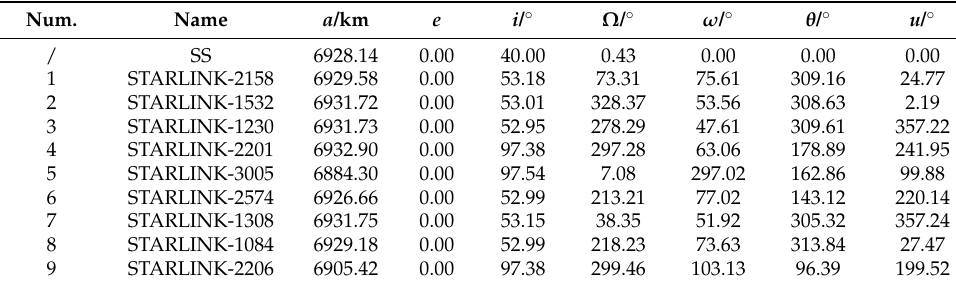
Table 1. SS and target satellite orbit parameters of example 1. Num.